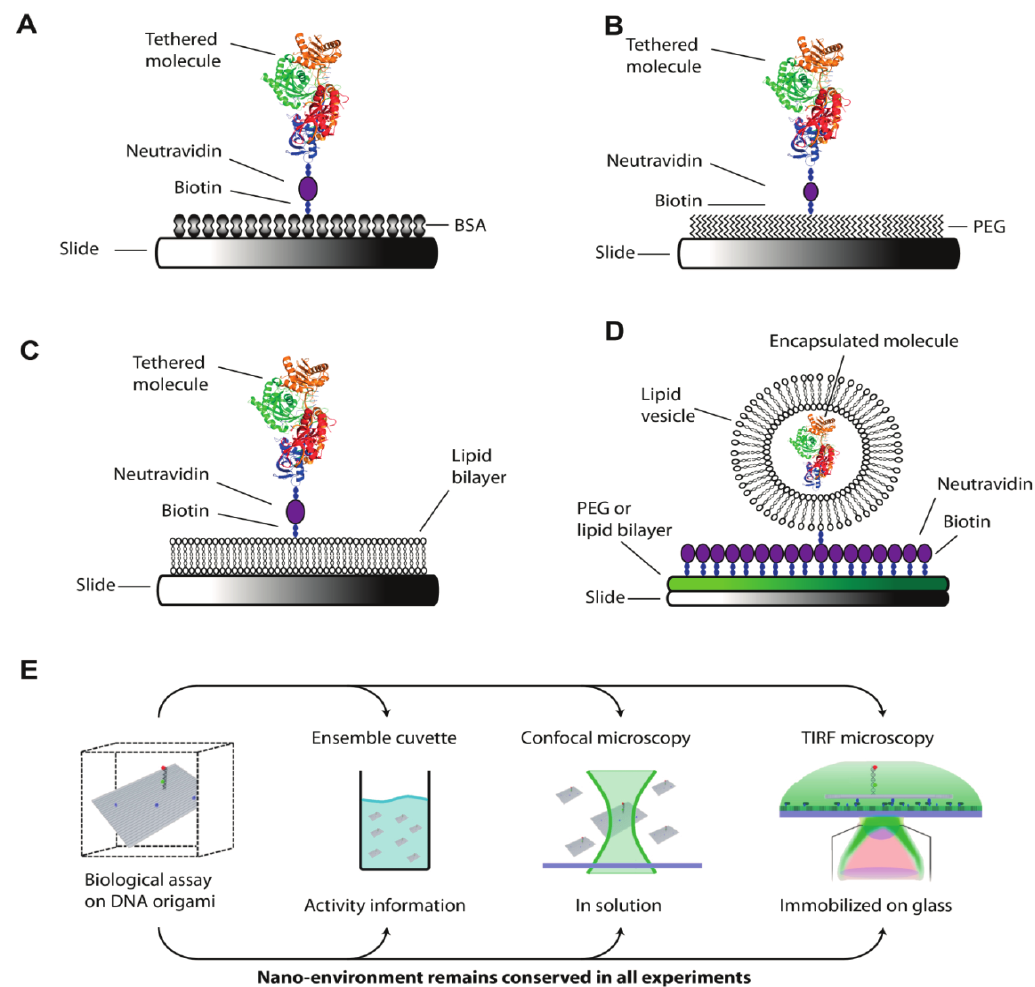
Figure 6. Immobilization and passivation strategies for single-molecule measurements on surface-tethered molecules. Passivation of the glass slide prevents the unspecific attachment of the molecule of interest and is usually realized using biocompatible reagents like ( A ) bovine serum albumin (BSA); ( B ) polyethylene glycol (PEG) or ( C , D ) lipids. Mixing of the passivation reagent with its biotinylated counterpart and addition of neutravidin allows the immobilization of the molecule of interest via a biotin-neutravidin linkage on the passivated surface; ( E ) More elaborated strategies make use of pseudo-surfaces like DNA origami. The DNA origami serves as transportable and biocompatible platform that allows the matching of ensemble and single-molecule measurements (see text for details) [104]. (Figure in panel E adapted by permission from Oxford University Press. Gietl, A., et al. , 2012 “DNA origami as biocompatible surface to match single-molecule and ensemble experiments”. Nucleic Acids Research 40(14): e110. Figure